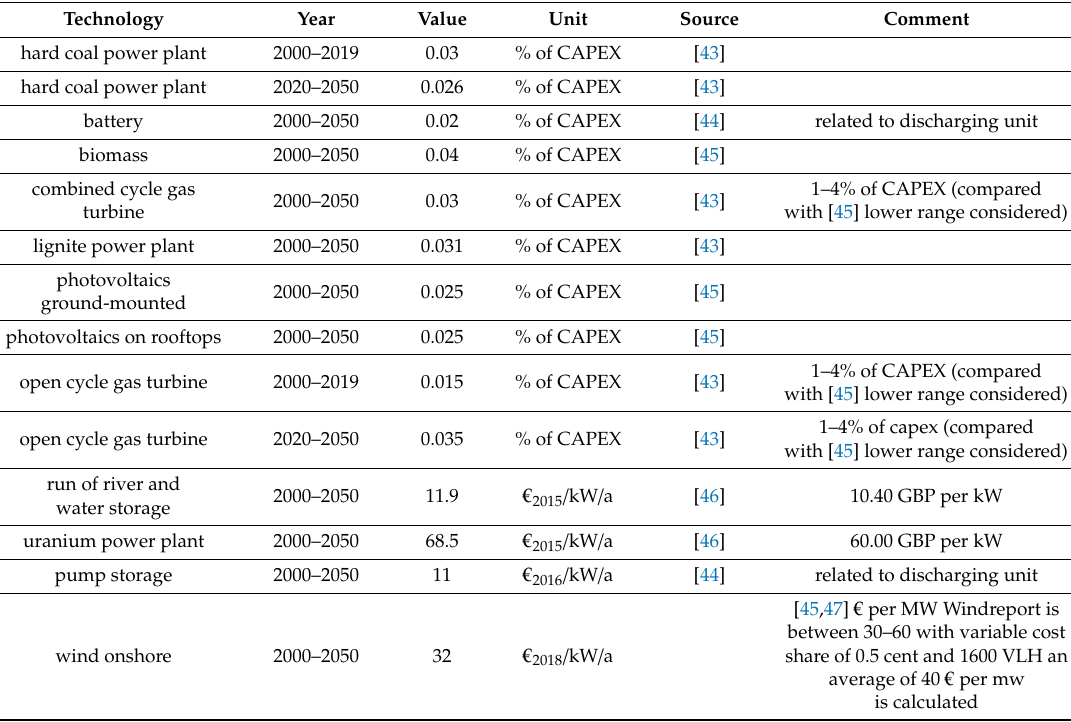
Table A3. Assumptions of fix cost per technology.